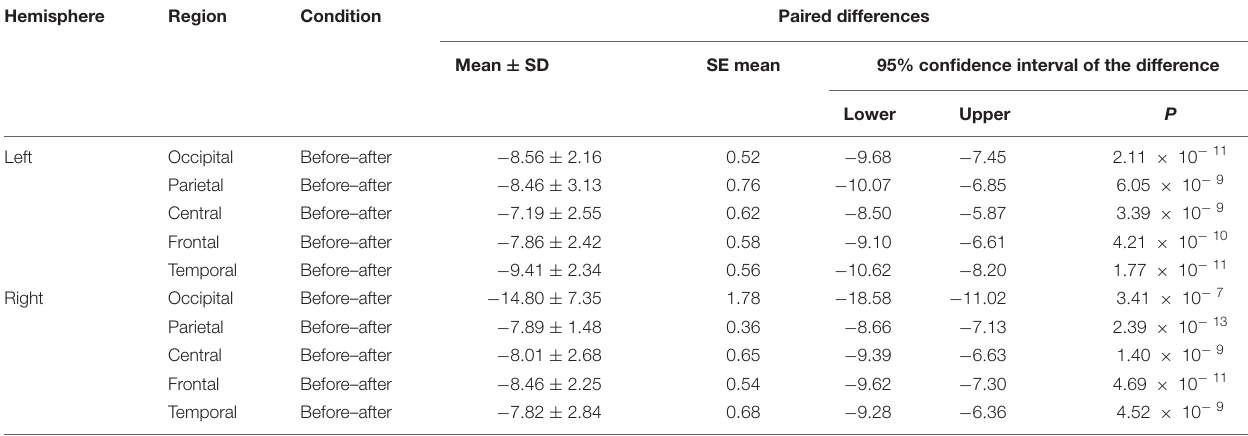
TABLE 6 | The results of paired t -test for average alpha power before and after each regional condition for healthy subjects. Hemisphere Region Conditions Paired differences Mean ± SD SE mean 95% confidence interval of the difference Lower Upper P Left Occipital